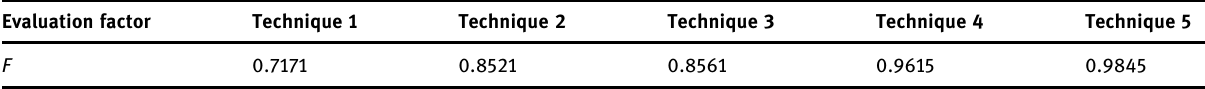
Table 1: The F values obtained by the di ff erent edge detection techniques Evaluation factor